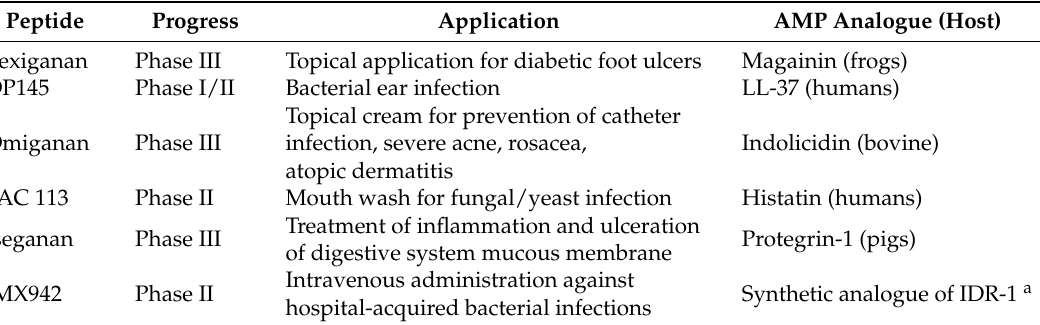
Table 2. Antimicrobial peptide in clinical trials